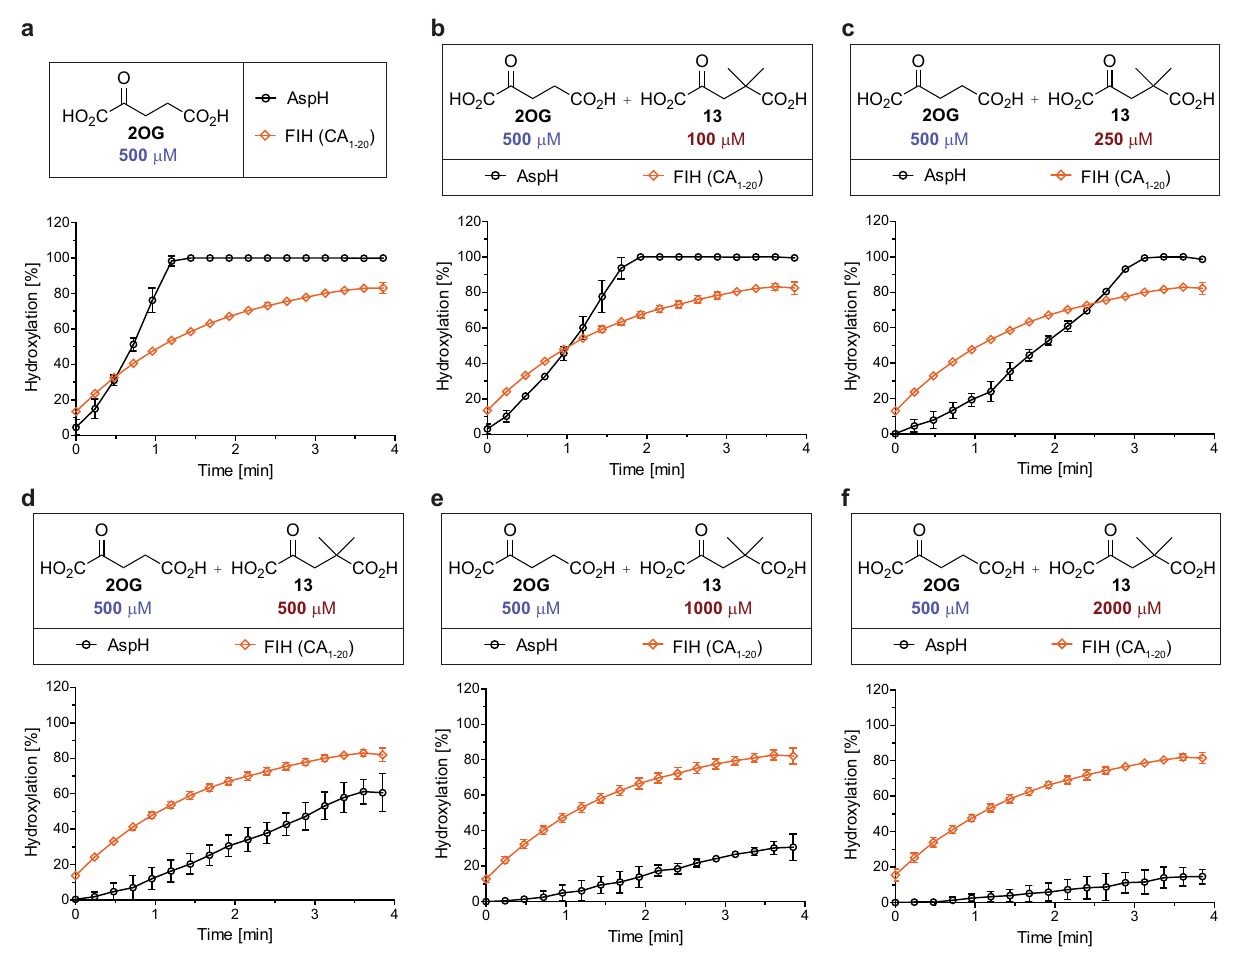
Fig. 4 4,4-Dimethyl-2OG selectively inhibits AspH in the presence of FIH at physiological 2OG concentrations. 2OG oxygenase assays were performed as described in the Methods section using 0.15 μ M of each 2OG oxygenase (diamond: FIH, circle: AspH) and 5.0 μ M of each substrate (orange: CA 1 – 20 47 ; black: hFX-EGFD1 86 – 124 -4Ser 31 , AspH substrate) in the presence of 100 μ M LAA, 10 μ M FAS, and the indicated concentrations of cosubstrates in buffer (50 mM Tris, 50 mM NaCl, pH 7.5). Mean of three independent runs ( n = 3; mean ± SD). Measurement times were normalized to the fi rst sample injection analyzed after the addition of 2OG oxygenase to the Substrate Mixture ( t = 0 min), by which time low levels of hydroxylation were manifest. Titration of 4,4-dimethyl-2OG ( 13 ) to a reaction mixture containing 500 μ M 2OG: a 0 μ M 13 ; b 100 μ M 13 ; c 250 μ M 13 ; d 500 μ M 13 ; e 1000 μ M 13 ; f 2000 μ M 13 . Source data are provided as a Source Data fi be ~0.2 μ M. Analysis of a Cornish-Bowden plot 63 further supports a 2OG-competitive inhibition mode, i.e., parallel lines for different 2OG concentrations are obtained when plotting [2OG]/ v against [ 18 ] and their intercept with the y axis increases on increasing the 2OG concentration (Fig. 5b). FIH was crystallized in the presence of Zn(II) and the 2OG derivatives 11 or 18 to investigate their binding modes. FIH